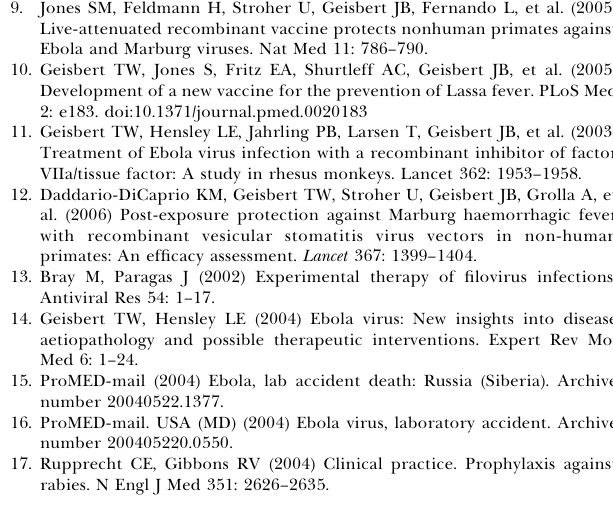
Figure S1. Weight Loss of Mice and Guinea Pigs Given Post-Exposure Treatment for ZEBOV Infection (A) Mice (groups of five animals) were infected with 1,000 LD 50 of MA-ZEBOV by i.p. injection. At various times points 24 h prior to challenge ( * ), 30 min after challenge ( ¤ ), or 24 h after challenge ( n ) they were treated with 2 3 10 5 pfu of VSV D G/ZEBOVGP by i.p. injection. The controls ( & ) were left untreated and all died. All treated animals survived the challenge.